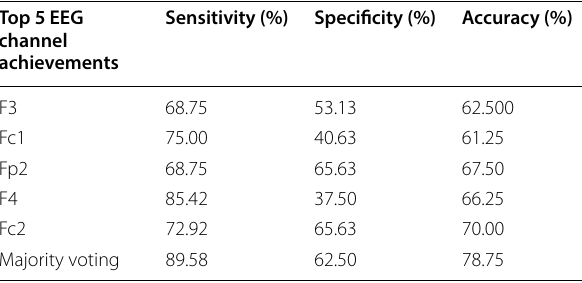
Table 9 Top 5 EEG channel achievements on theta rhythm for HA vs LA classification Top 5 EEG channel